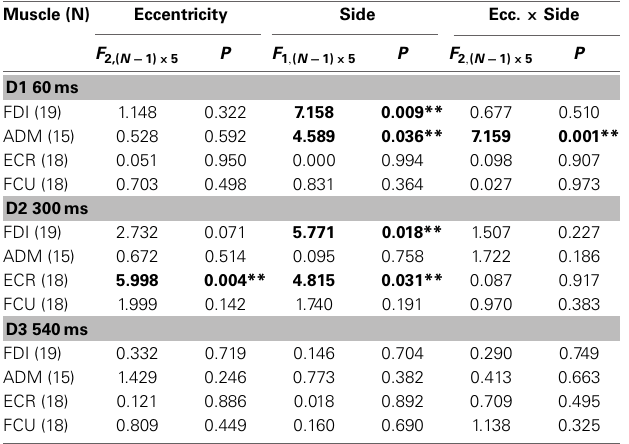
Table 1 | Two-Way repeated measures ANOVAs of MEP amplitudes. Muscle (N) Eccentricity Side Ecc. × Side